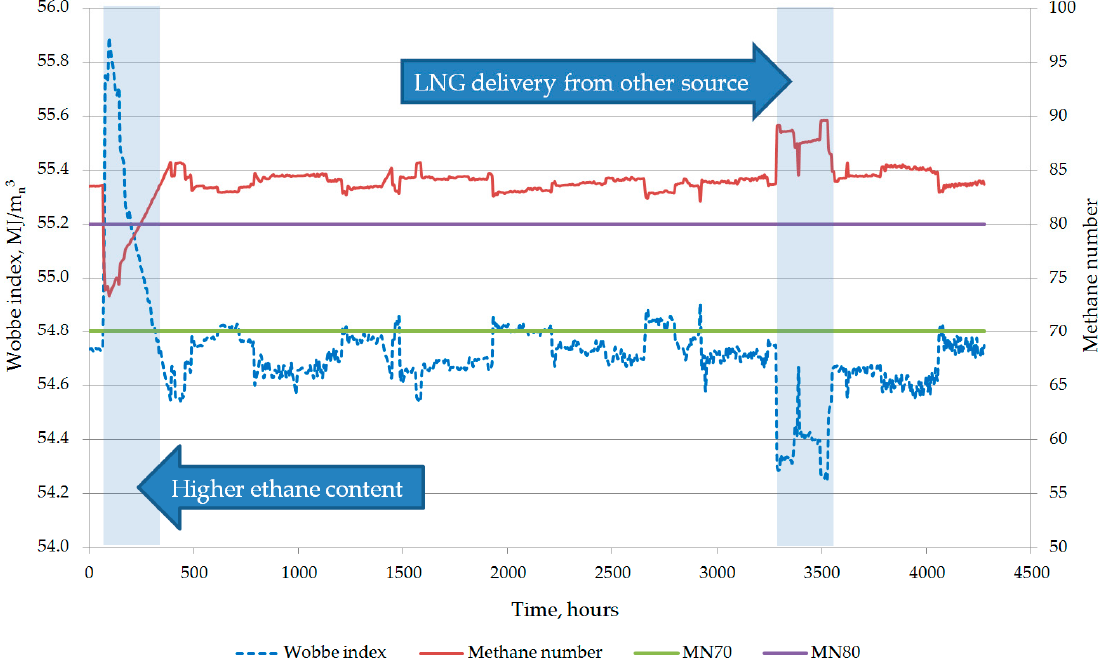
Figure 13. Methane number and Wobbe Index changes in exemplary. Operational conditions at LNG Terminal.